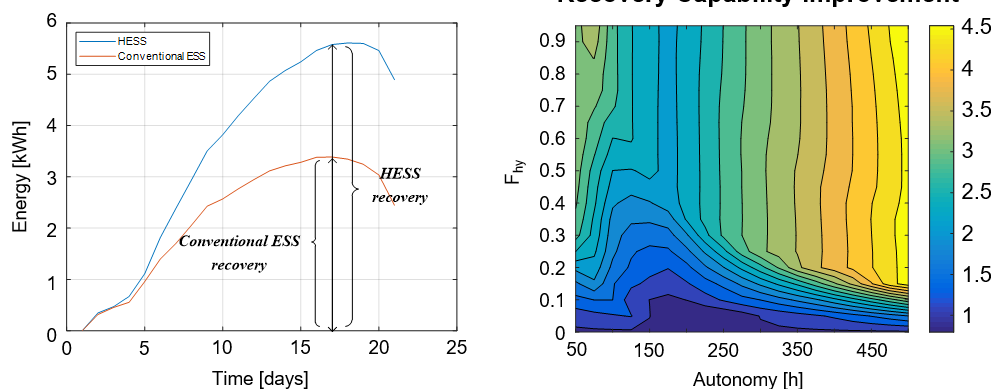
Figure 13 . Additional harvested energy in a sample case ( a ), Recovery capability improvement in the design space ( b ).